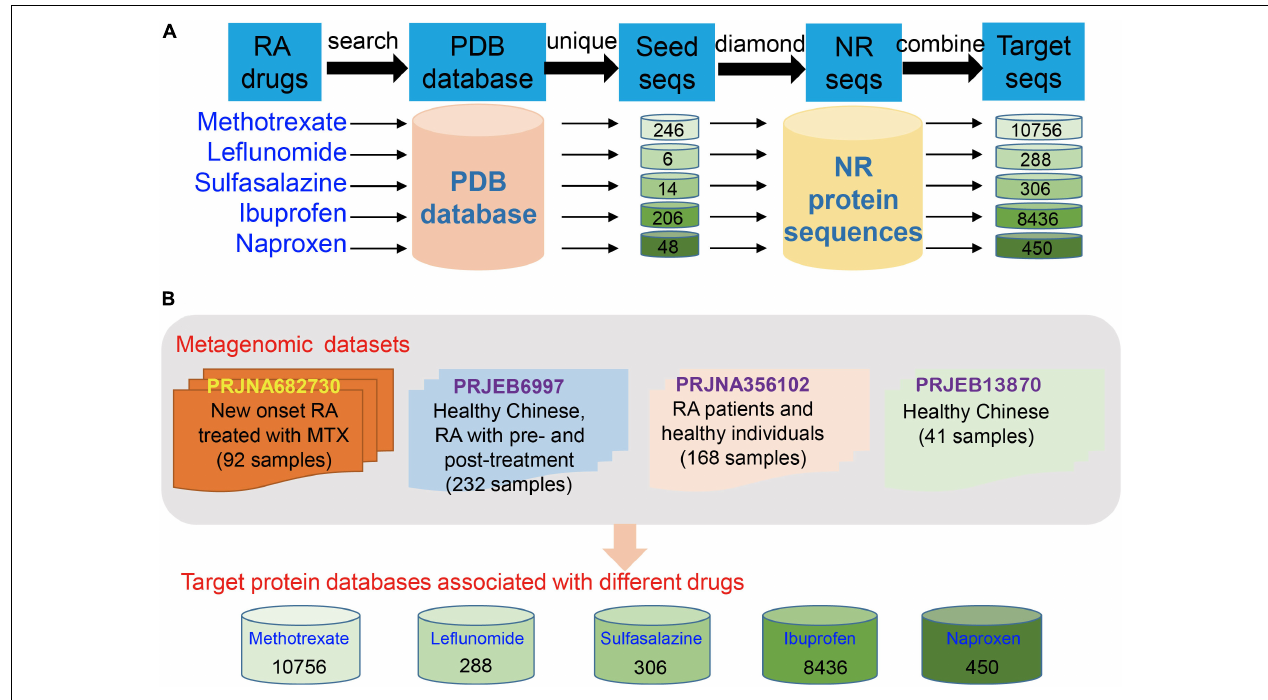
FIGURE 1 | Construction of protein databases for clinical drugs in rheumatoid arthritis (RA) treatment and the human gut metagenome datasets used in the present study. (A) Construction of databases for detection of proteins and the corresponding genes involved in drug metabolism in the gut microbial communities of RA patients. (B) Gut metagenome datasets used in this study were collected from four cohorts, namely, BioProject PRJNA682730, PRJEB6997, PRJNA356102, and PRJEB13870 (only the dataset of healthy individuals was